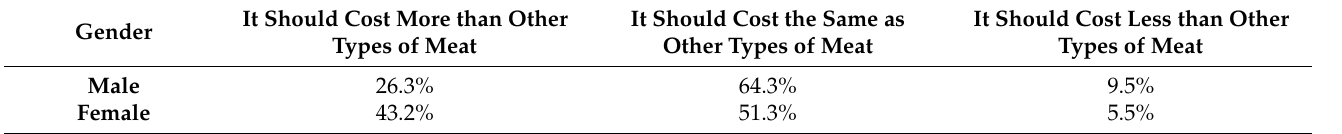
Table 10. How do you perceive the price of game compared to other types of meat ( n = 523)? It Should Cost More than Gender